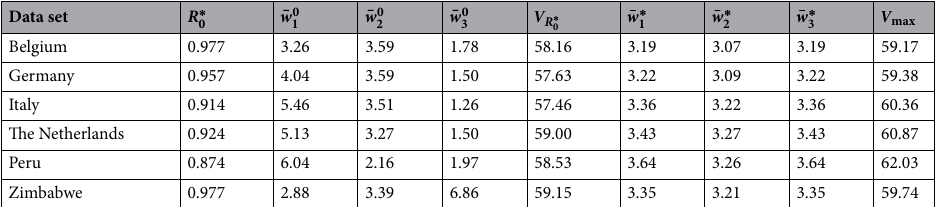
Table 2. Mean vaccination coverage (in % ) at the vaccination strategy { ¯ w 0 i } (in % ) leading to the minimum R ∗ 0 at the DFE, and at the vaccination strategy { ¯ w ∗ i } (in % ) computed from Eq. (3) leading to the maximum mean vaccination coverage. In both cases, the mean per capita vaccination rate ¯ w = ¯ w c , and 100% vaccine efficacy is assumed. Parameters: γ 1 = 1 , γ 2 = 1 , γ 3 = 0.9 , δ v 1 = 1 / 40 , δ v 2 = 1 / 52 , and δ v 3 = 1 / 40 . For each country, β is scaled such that R 0 = 2.5 in the absence of vaccinated